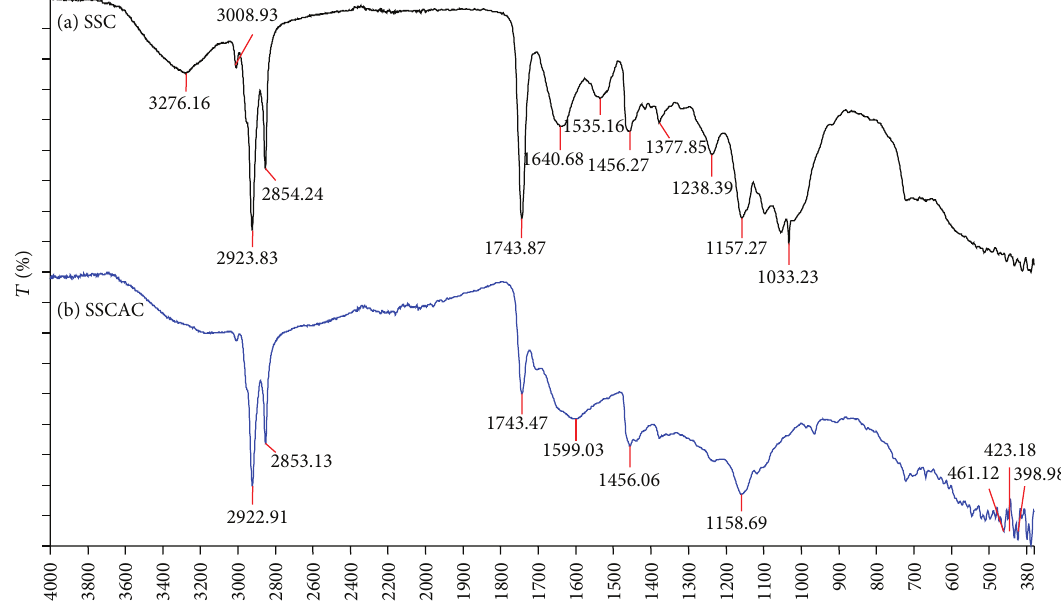
Figure 1: FT-IR spectrums of (a) sunflower seed cake. (b) activated carbon obtained at 350 ∘ C.